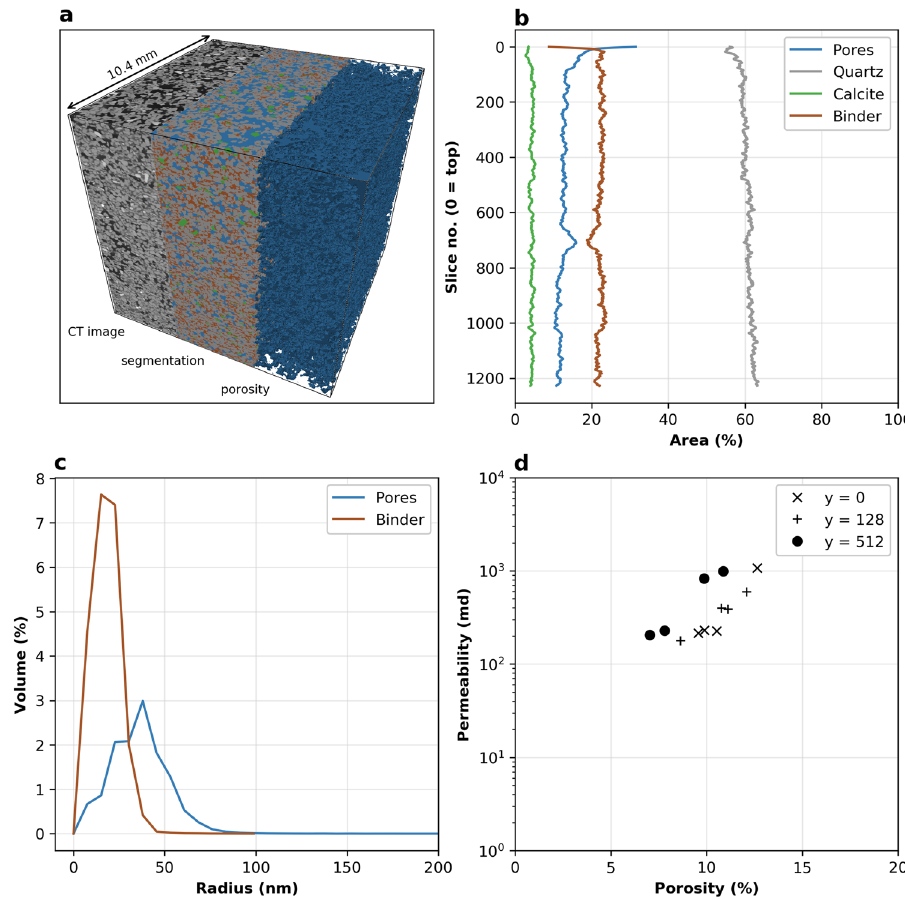
Fig. 4 a 3D rendering show- ing the processed CT image, the machine-learning based segmentation and the voxel- rendering of the connected pore space. b Slice-wise area distribution of the segmented phases showing a slight increase in quartz content from top to bottom. The first 100 slices are characterised by an increased porosity and solid contents indicating lower compaction at the top. c The calculated pore and binder size distributions indicate that the binder primarily occupies narrower intergranular